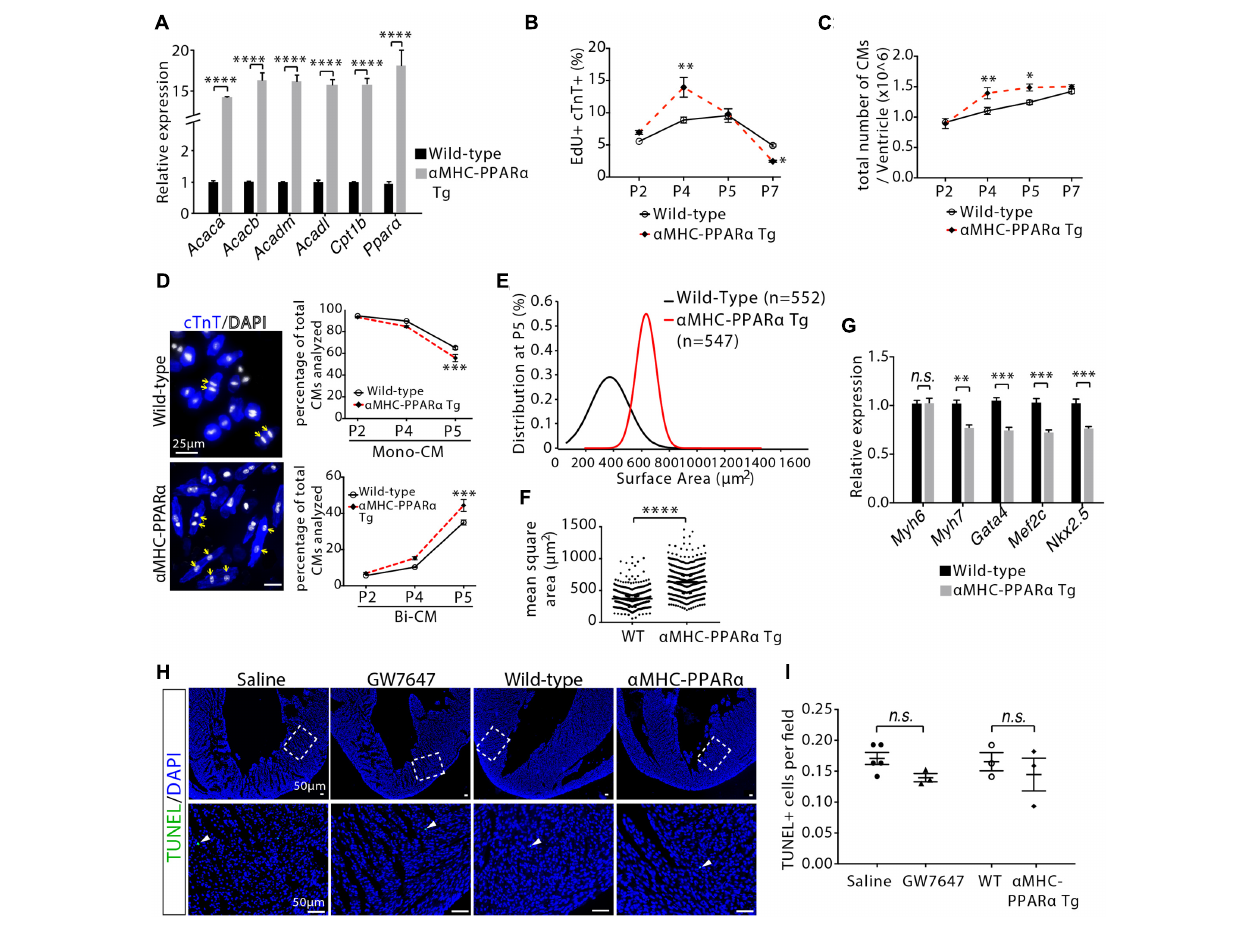
FIGURE 6 | Cardiomyocyte proliferation and hypertrophic growth in α MHC-PPAR α transgenic (Tg) hearts. (A) Quantification of genes associated with fatty acid metabolism by qRT-PCR analysis of the mRNA of isolated heart ventricles at P5 ( n = 4 per group). (B) Quantification of EdU+cTnT+ cells as percentage of total cTnT+ cells isolated from heart ventricles at indicated time points ( n = 6 per group, ∼ 1000 cTnT+ cells per sample). (C) Quantification of total number of cardiomyocyte isolated from heart ventricles at indicated time points ( n = 4–9 per group). (D) Representative images of isolated cardiomyocytes from P5 heart ventricles and quantification of the percentage of mononucleated (Mono-CM) and binucleated (Bi-CM) cardiomyocytes ( n = 4–6 per group, ∼ 1000 cTnT+ cells per sample). Arrows point to Bi-CM. cTnT (blue). DAPI (gray). (E,F) The frequency distribution (E) and mean square areas (F) of the surface area of cardiomyocytes isolated from α MHC-PPAR α transgenic and wild-type (WT) heart ventricles at P5. (G) Quantification of genes associated with cardiomyocyte maturation by qRT-PCR analysis of the mRNA of isolated heart ventricles at P5 ( n = 4–5 per group). (H,I) Immunostaining (H) and quantification (I) of TUNEL (green) and DAPI (blue) in P5 heart sections. The images in the second row are the enlargement of the bracketed regions shown in the top row. P value was calculated using Student’s t -test (A,F,G,I) and one-way ANOVA (B–D)